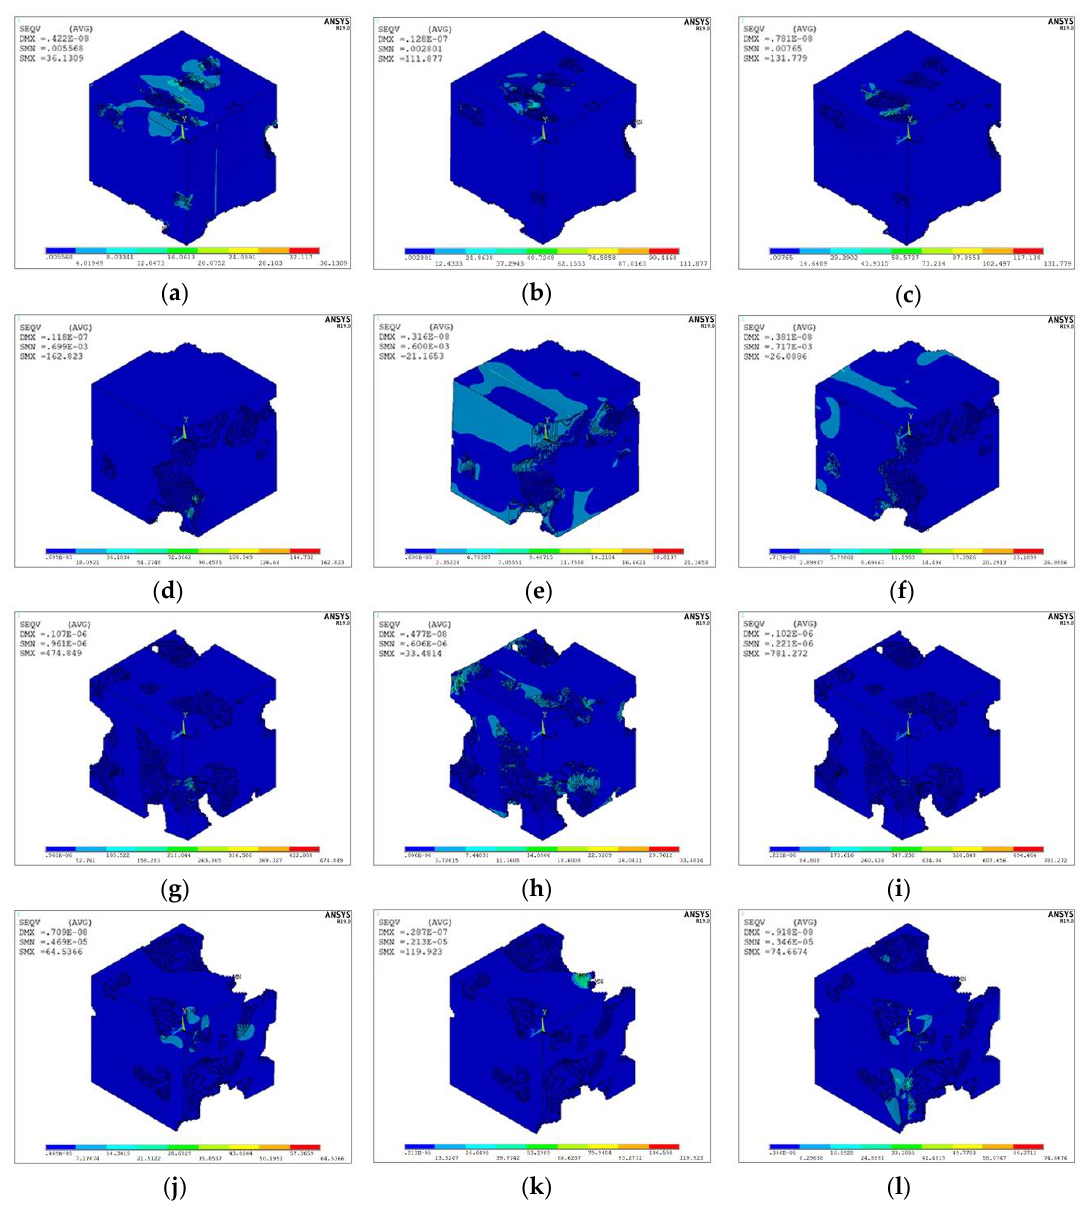
Figure 12. Equivalent stress analysis results of micron silver sintered joints under different thermal shocks by fixing X, Y and Z planes, respectively: ( a – c ) 50; ( d – f ) 100; ( g – i ) 150; ( j – l ) 250 cycles.